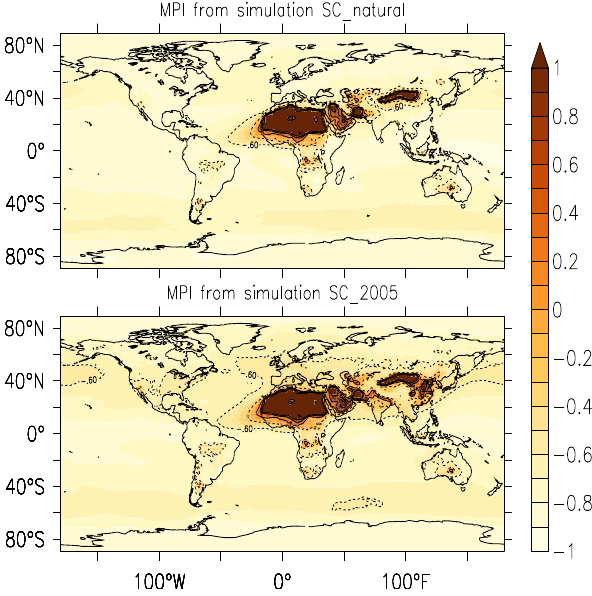
Fig. 9. Multi Pollutant Index (MPI) as calculated from simulation SC natural and from simulation SC 2005 . The contours are shown at multiples of 0.4.